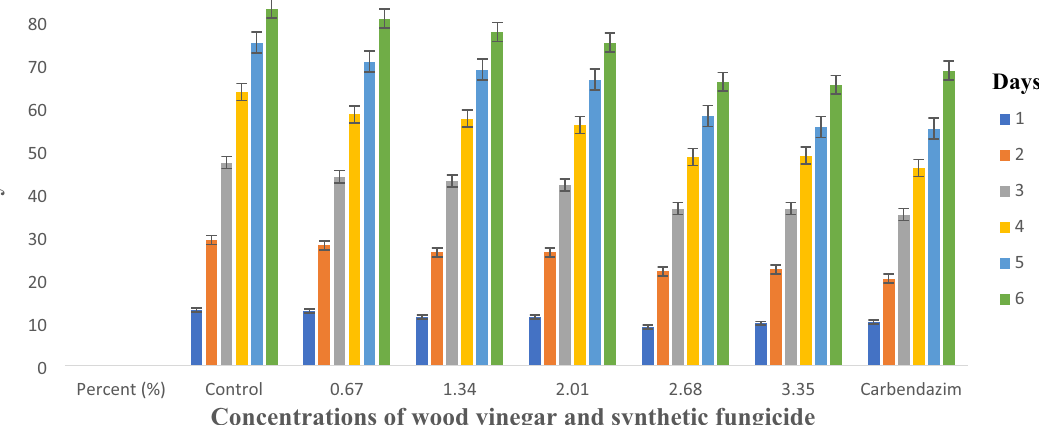
Figure 5. Average daily growth rate of Curvularia species on different concentrations of wood vinegar and Carbendazim